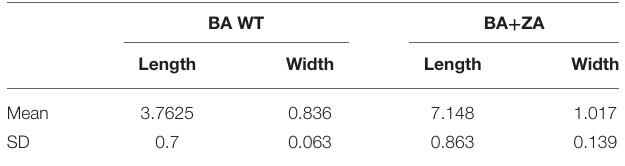
Frontiers in Microbiology |